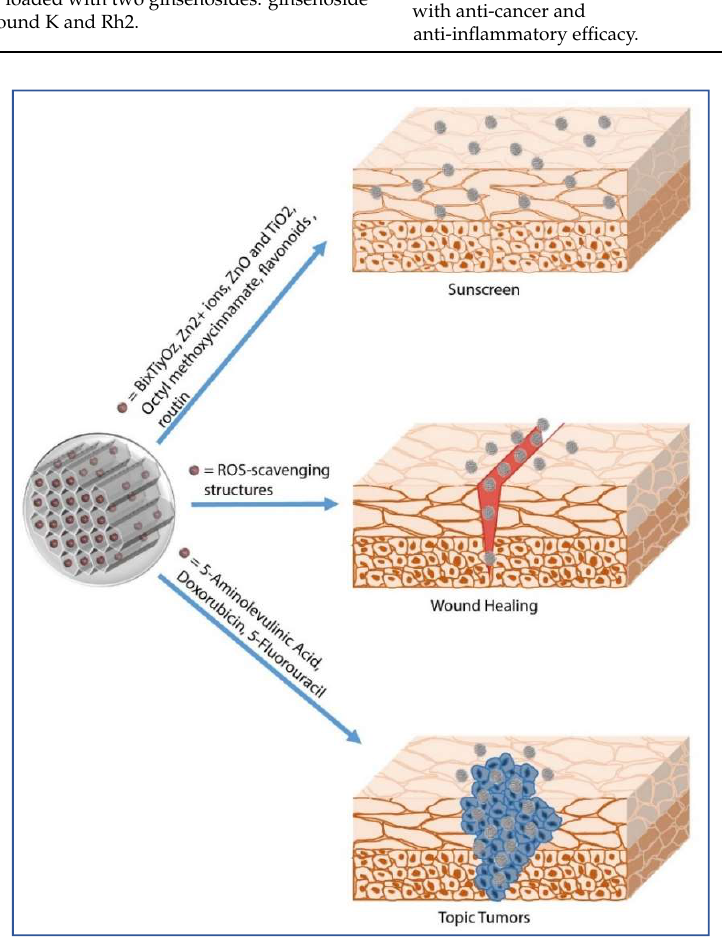
Figure 1. MSNs as topical drug delivery systems.